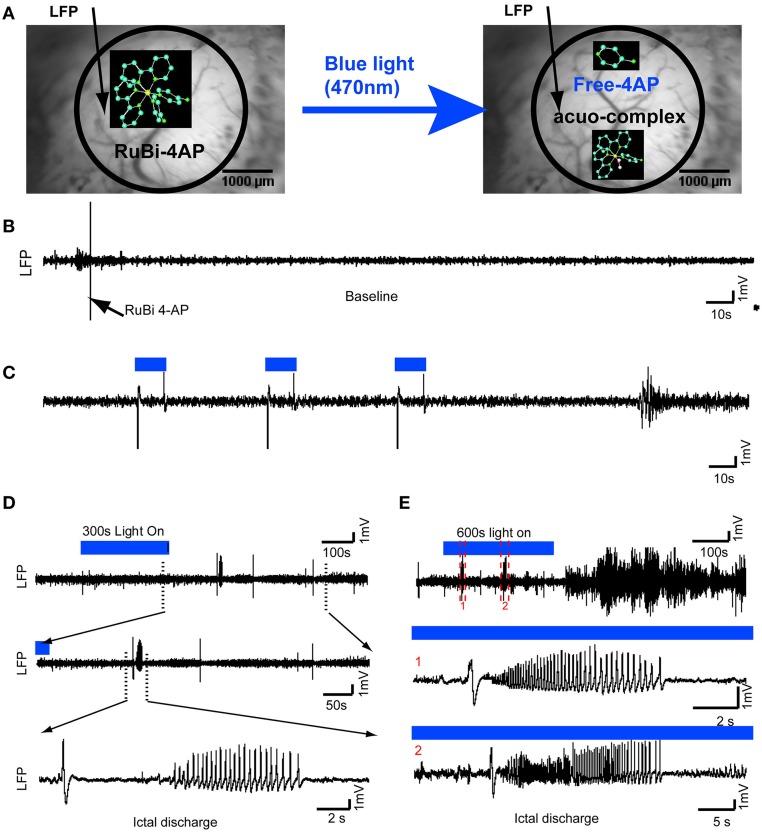
Optical triggering of epilepsy using topical application of RuBi-4-AP in vivo. (A) Schematic diagram of experimental design. RuBi-4-AP (0.1 ml, 15 mM) is topically applied to induce seizures. RuBi-4-AP is stable in ACSF solution (Left) and the 4-AP and ruthenium complex are photoreleased with visible 470 nm blue light (Right). The black arrow on the image of the cortical surface indicates the LFP electrode. (B) 5 min baseline LFP recording shows normal brain activity after RuBi-4-AP application before uncaging. (C) Interictal discharges and polyspikes are induced by 10 s blue light illumination (470 nm, 1.2 A) over the neocortex. The duration of illumination is shown with a blue line (Top). (D) Ictal discharge is induced by 300 s blue light pulses. The expanded view (Bottom) shows a typical ictal discharge starting with an initial spike (ictal onset). (E) Ictal-like activity is also induced by longer, 600 s, illumination. Ictal discharges are recorded during illumination and even after the blue light is turned off (Top). The middle (1) and bottom panels (2) show expanded views of two ictal discharges in the upper panel.